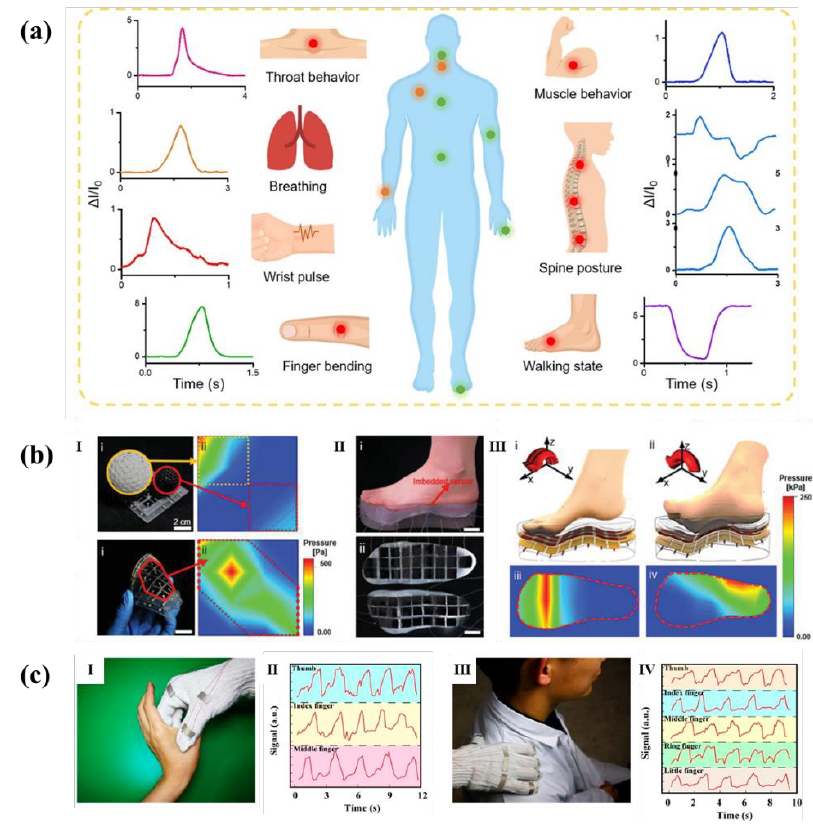
Figure 14. Microstructed flexible pressure sensors used in ( a ) monitoring the movement of the spine, throat and the body [60], ( b ) detecting foot pressure distribution [118], and ( c ) smart gloves [119].